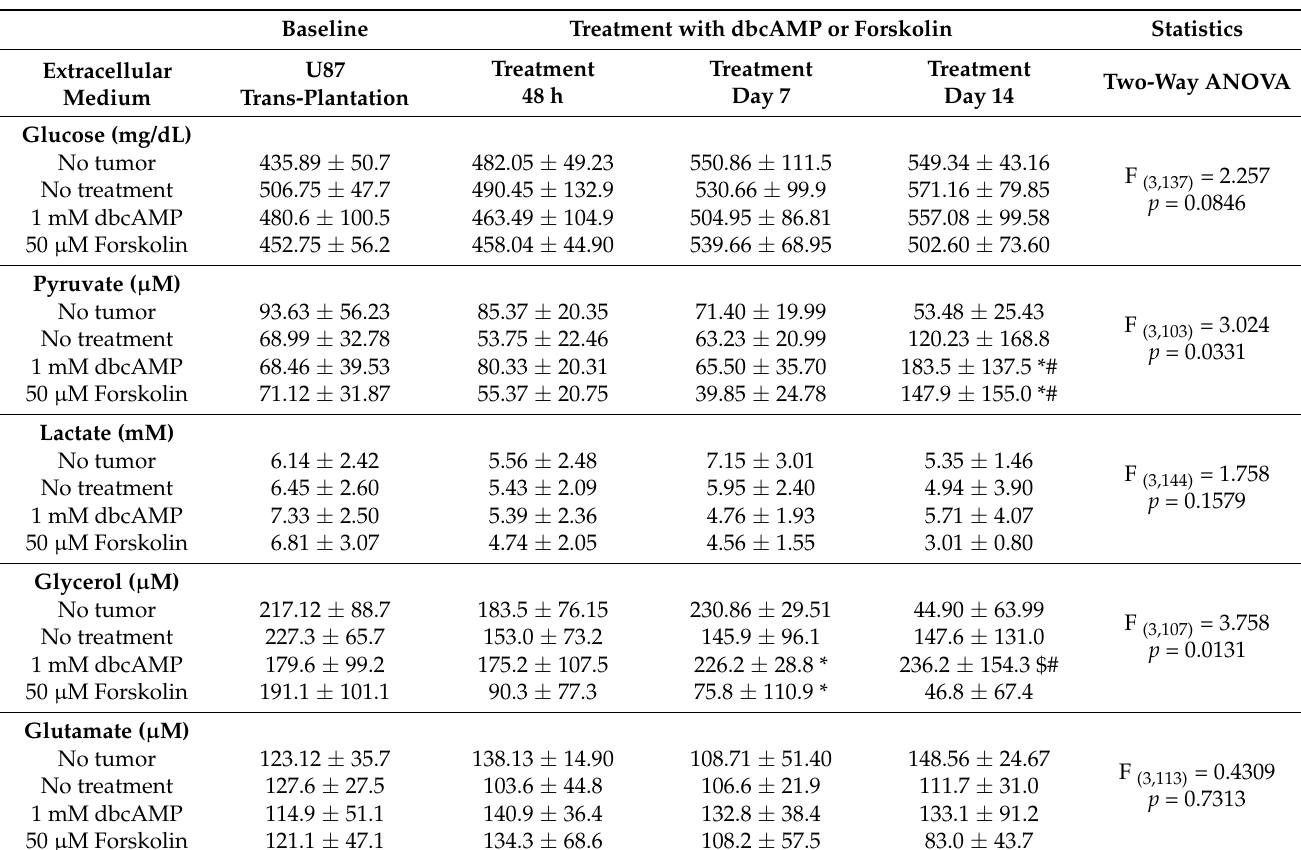
Table 1. Assessment of metabolic effects in the culture medium of the glioblastoma cell line U87 co-cultured with organotypic brain slices over time. Data are expressed as mean ± SEM (n = 8 per group) for p < 0.5. * difference compared to No treatment. # difference compared to No tumor. $ difference compared to Forskolin. F is the ratio of the model to its error and is calculated by dividing the mean of squares for the model and the residual mean